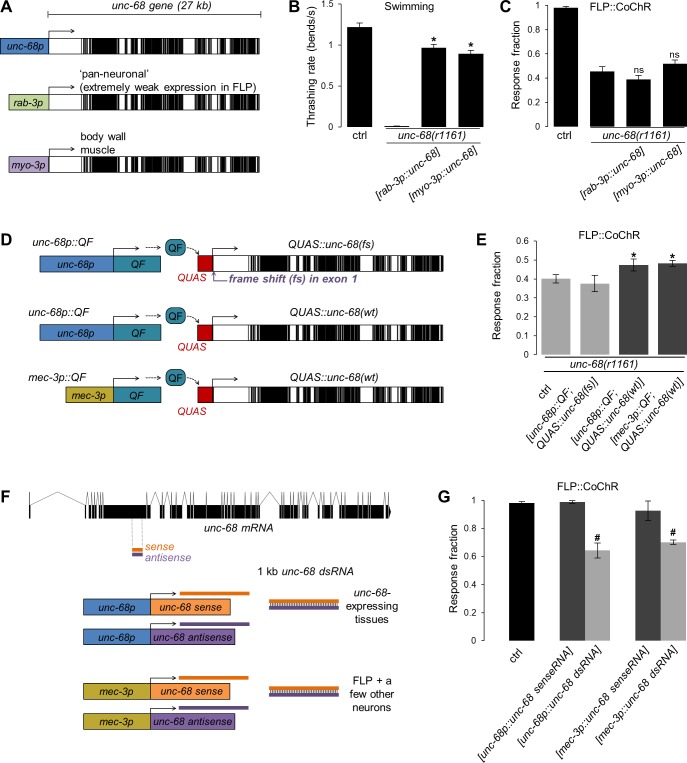
UNC-68 functions cell-autonomously in FLP to control reversal induction.A: Schematic of the transgenes used for muscle- and neuron-specific rescues of unc-68. Note that the rab-3 promoter drives almost undetectable expression in FLP neurons (S4 Fig). B, C: Expression of unc-68 with the myo-3 or rab-3 promoter is sufficient to rescue the swimming defect (B), but not the FLP-evoked reversal defect (C) in unc-68(r1161) mutants. *, p < .01; ns, not significant versus unc-68(r1161) control by Dunnett’s tests. n≥38 animals (B) and n≥80 animals (C). Bars indicate averages (+/- SEM). D: Schematic of the QF/QUAS two-component system used to drive unc-68 expression in FLP with the mec-3 promoter. Different plasmids (left) are used to drive the expression of the transcription factor QF in the desired tissue. QF can then bind to the QUAS promoter in a co-injected fosmid to drive the expression of a functional unc-68(wild type) transgene or a non-functional unc-68(fs) (frame shift) transgene. E: Rescue of the unc-68(r1161) FLP-evoked reversal defect with the constructs shown in D. Bars indicate averages (+/- SEM). n≥80 animals. *, p < .01 versus unc-68(r1161) control by Dunnett’s tests. For each genotype, data are pooled from at least two independent transgenic lines showing similar results. F: Schematic of the unc-68 constructs used to downregulate unc-68 expression in specific tissues by RNAi. G: FLP-evoked reversal analysis showing the impact of tissue-specific unc-68 RNAi. Bars indicate averages (+/- SEM). n≥80 animals. *, p < .01 versus wild type and respective sense controls by Bonferroni post-hoc tests. For each genotype, data are pooled from at least two independent transgenic lines showing similar results.